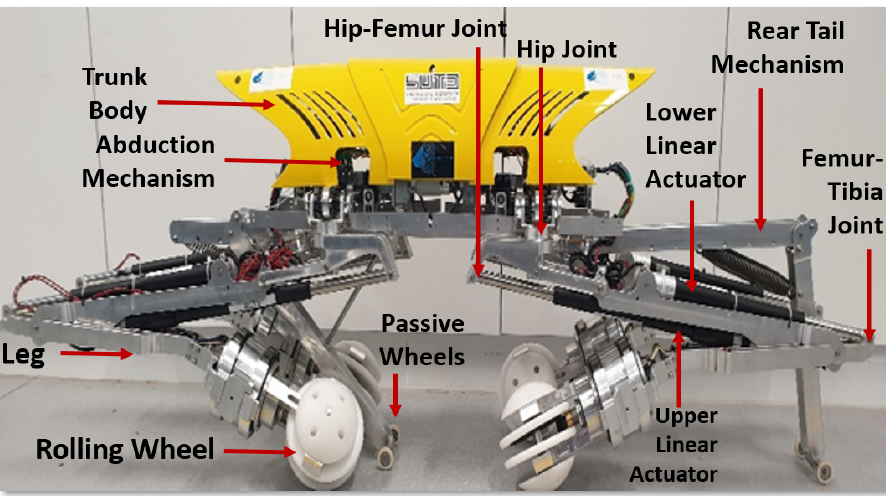
Figure 2. Tarantula-II Platform showing the different